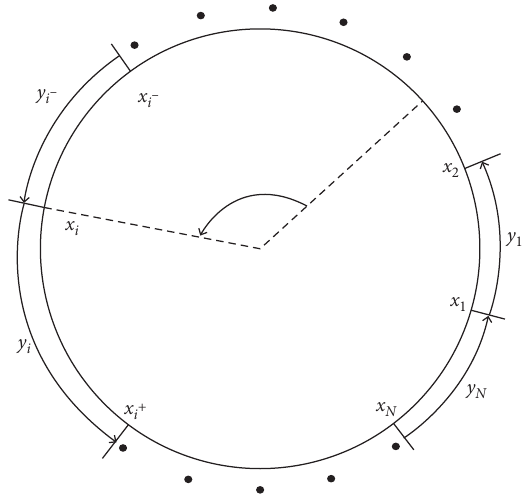
Figure 1: Mobile agents located on a